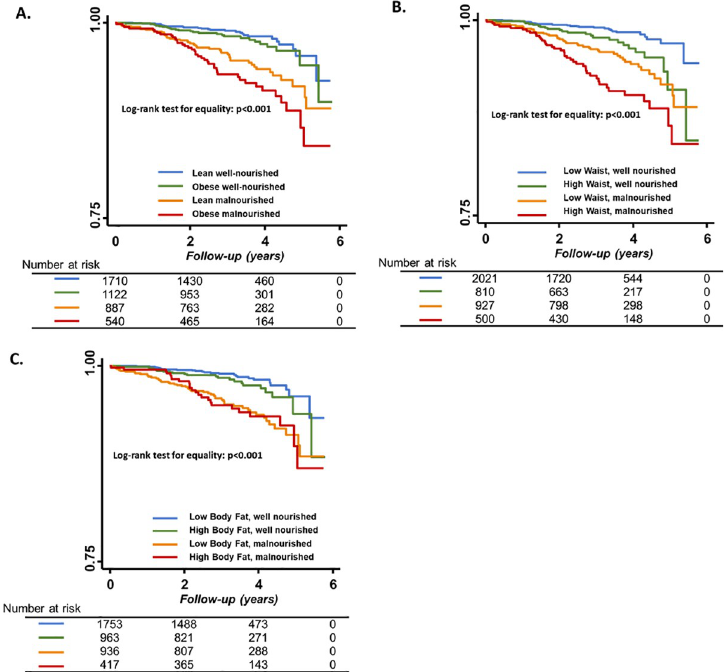
Fig 2. Kaplan–Meier survival estimates for composite outcome of heart failure hospitalization and 1-year mortality. Participants are stratified by combined subgroups of nutritional index (serum albumin) and (A) body mass index (high, > 25 kg/m 2 ), or (B) waist circumference (high, > 90 cm and > 80 cm in men and women, respectively), or (C) percentage body fat ( > 25% and > 35% in men and women, respectively).